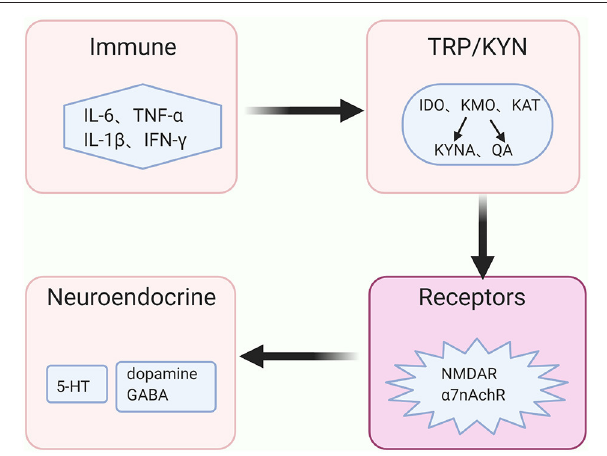
FIGURE 3 | The immune-KYN-neuroendocrine network in BD. The abnormal immune system in bipolar disorder (BD) aberrantly activates the key enzymes’ activities of the kynurenine (KYN) pathway, shifts the tryptophan (TRP) from serotonin (5-HT) toward kynurenine (KYN) pathway for metabolism, and causes the reduction of 5-HT. Levels and functions of other neurotransmitters, such as dopamine, γ -aminobutyric acid (GABA) as well as glutamate, rely on the metabolites of the KYN pathway in coordinating with distinct receptors, such as N-methyl-D aspartate (NMDA) receptor and non-competitively α 7 nicotinic acetylcholine receptor ( α